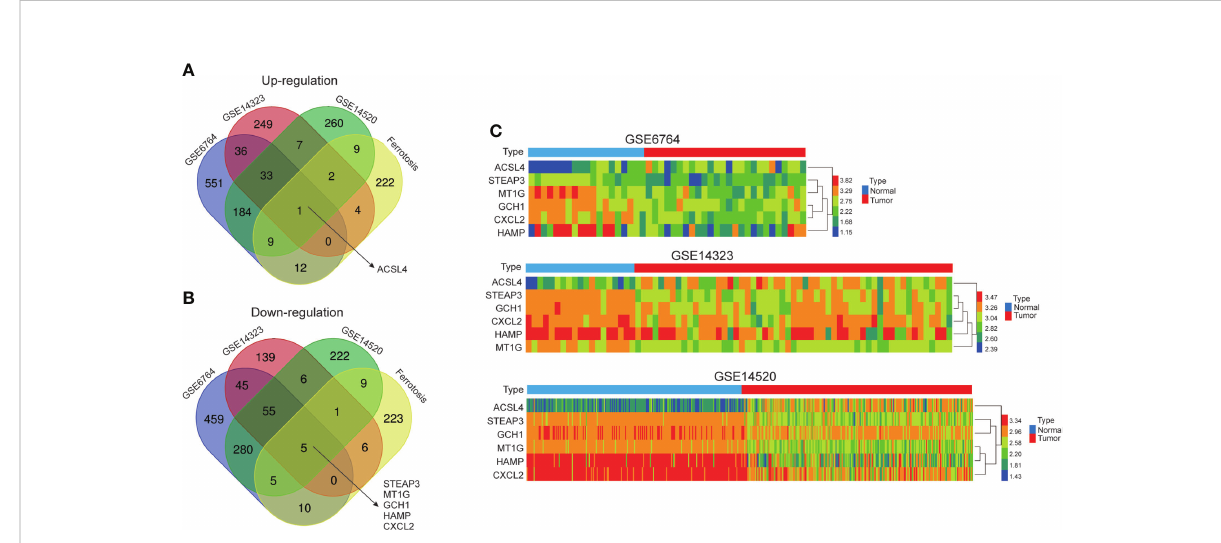
FIGURE 1 Identi fi cation of co-differentially expressed genes (co-DEG). (A, B) Venn diagrams exhibited one up-regulated gene, ACSL4, and fi ve down- regulated genes, STEAP3, MT1G, GCH1, HAMP, and CXCL2, between three HCC GEO datasets and ferroptosis-related gene set. The number in overlapping area represents the number of genes. (C) The gene expression heatmaps of co-DEGs in GSE6764, GSE14323,